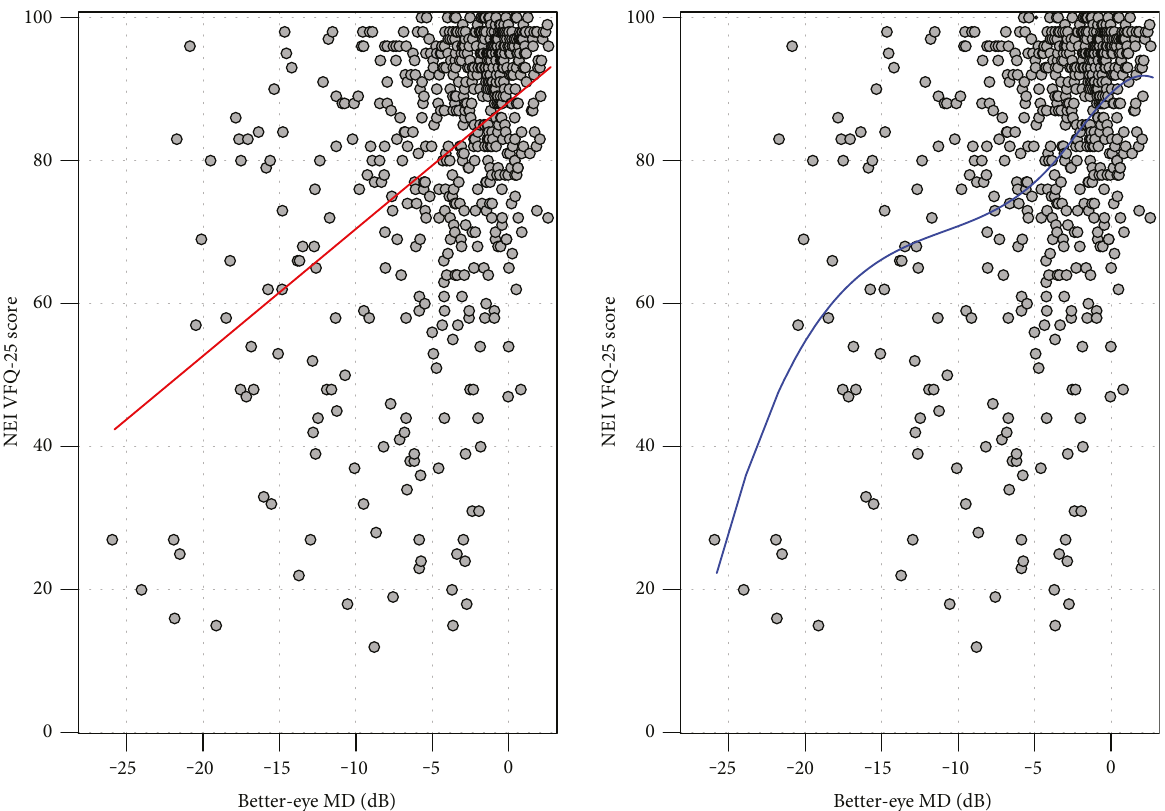
Figure 1: Points represent scores on NEI VFQ-25 compared to BEMD (dB) for 636 patients. The use of linear (red line) and spline (blue line) regression modelling assessing trend in relationship between the two